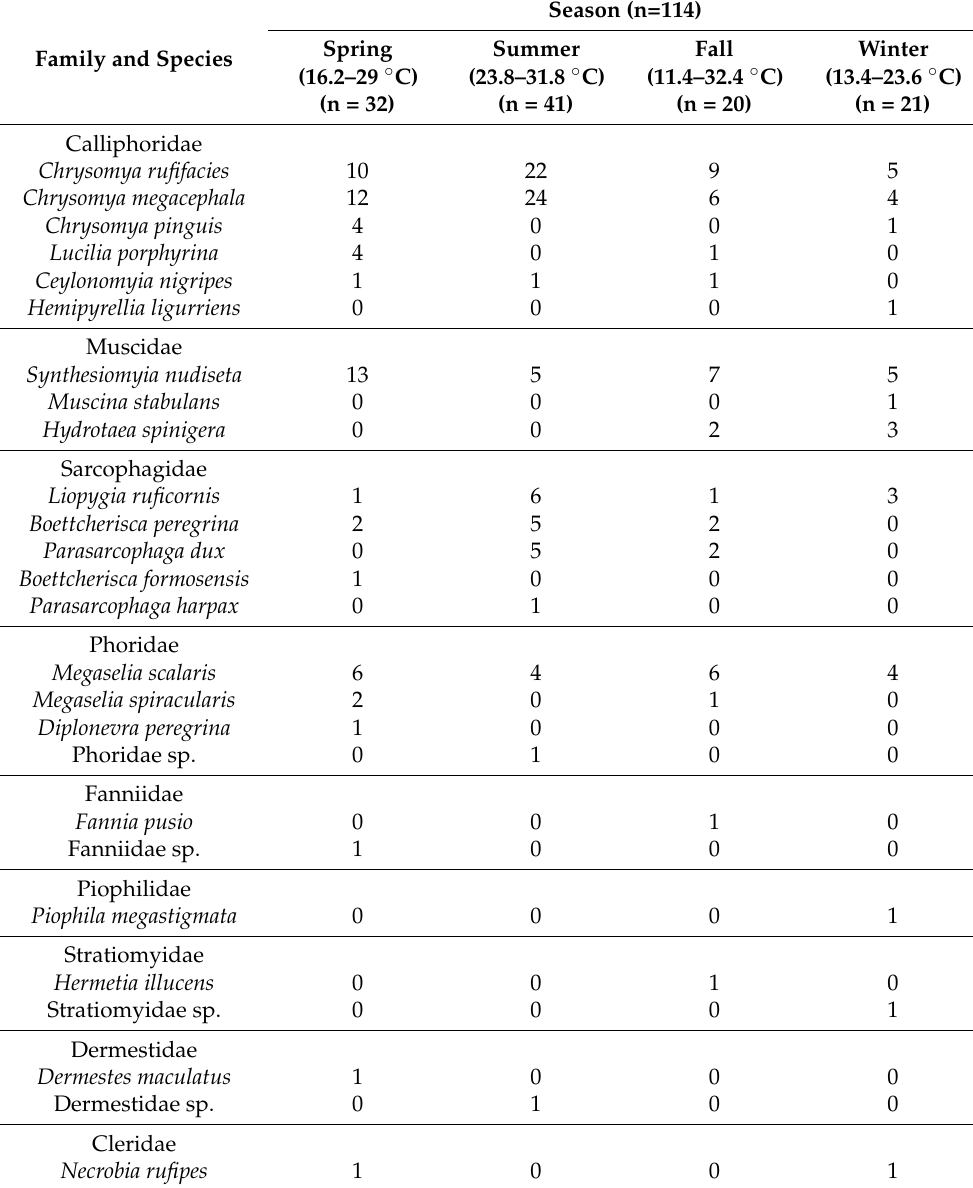
Table 3. Case frequency of insect species collected in different seasons. (n, number of